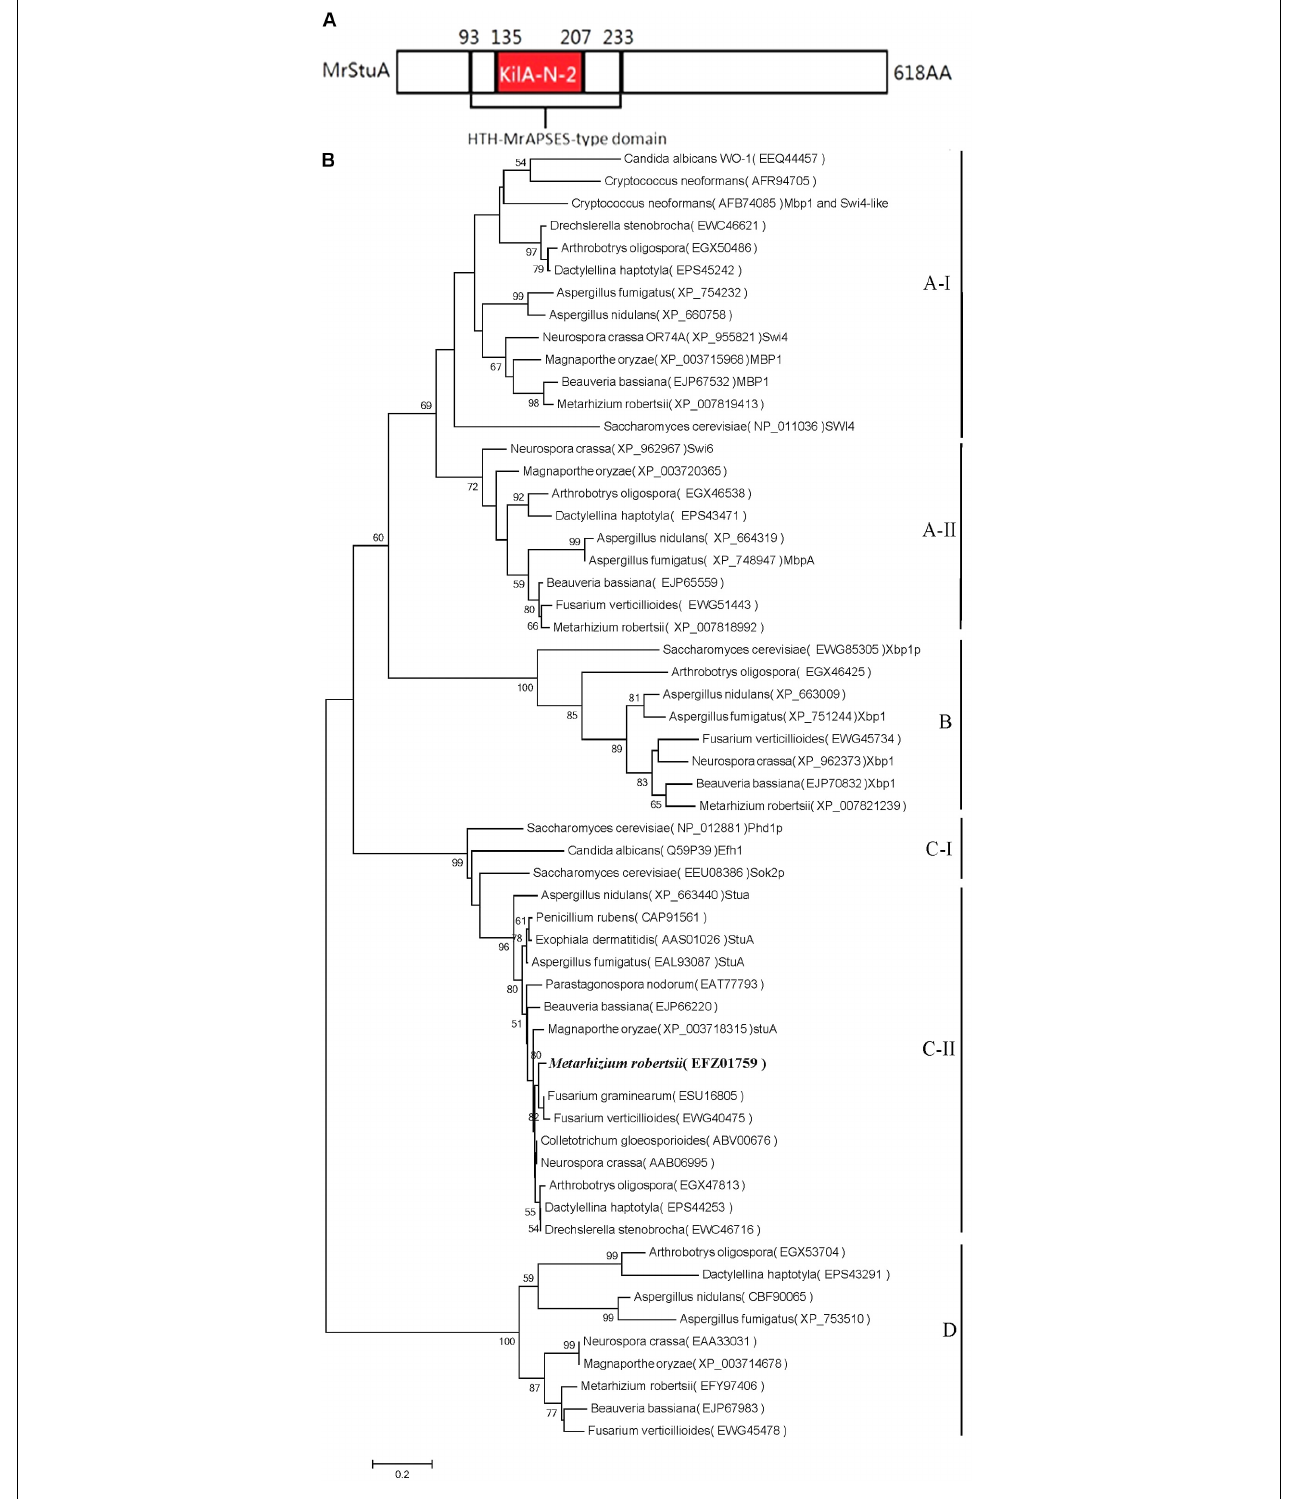
FIGURE 1 | Bioinformatics analysis of the MrStuA protein. (A) Peptide domain analysis of the APSES transcription factor from M. robertsii. (B) A phylogenetic tree based on the APSES-type DNA-binding domains from different fungi. Bootstrap values (expressed as percentages of 1000 replications) greater than 50% are indicated on the tree. Numbers below the nodes indicate the bootstrap values. The bar markers indicate genetic distances, which are proportional to the number of amino acid substitutions.